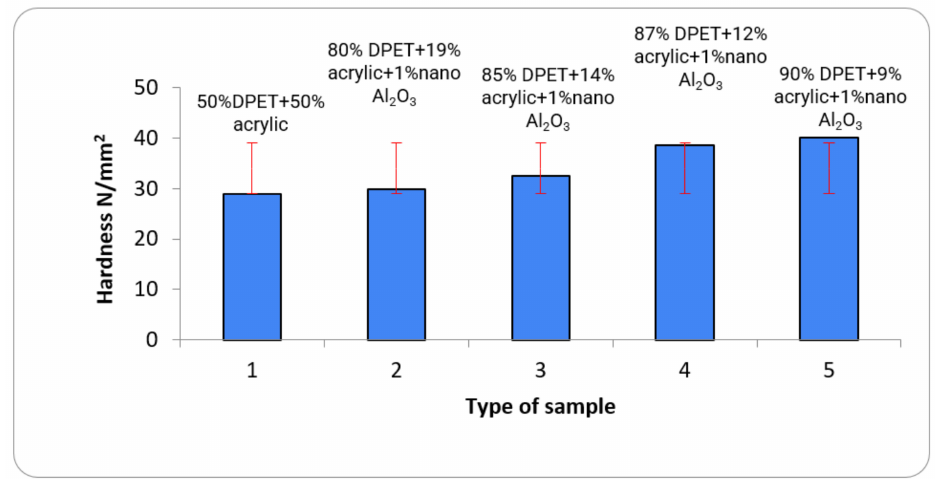
Figure 5. Effect of DPET addition on composite coating hardness.